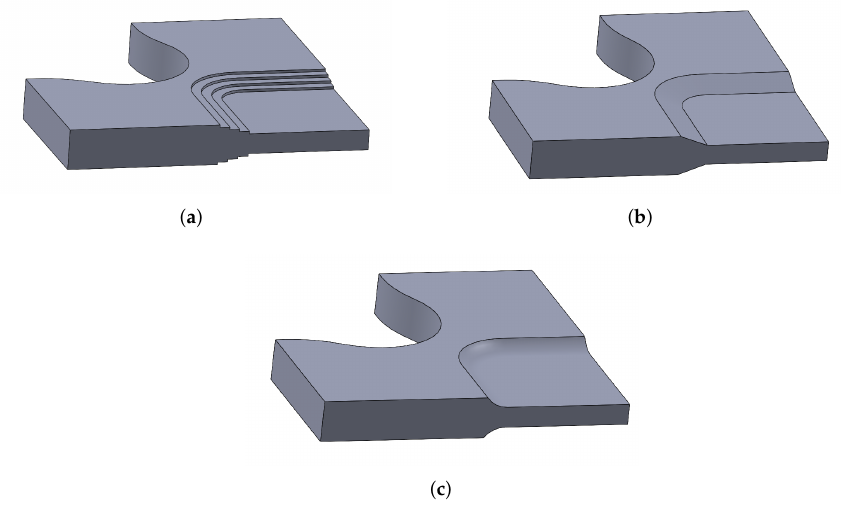
Figure 4. 3D model of a quarter of cruciform specimen presenting different techniques for thickness tapering: ( a ) Stepped transition. ( b ) Linear reduction. ( c ) Curved